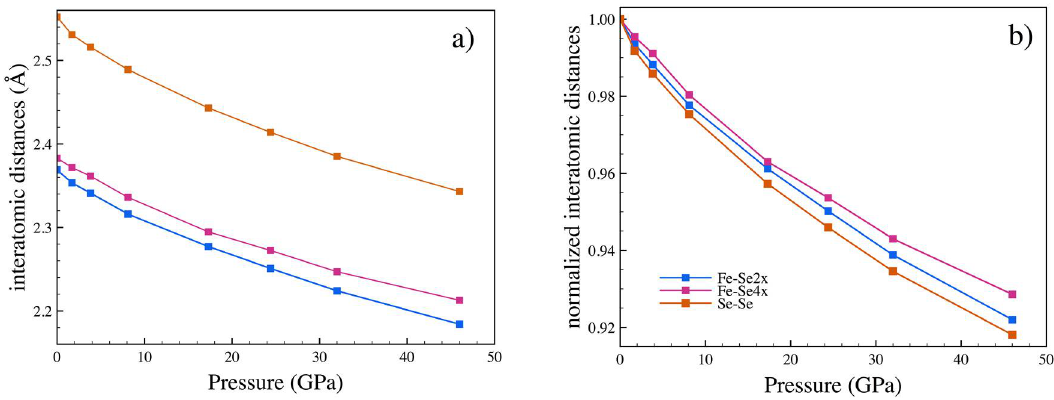
Table 2. Unit-cell parameters and atomic fractional coordinates of ferroselite at high pressure.